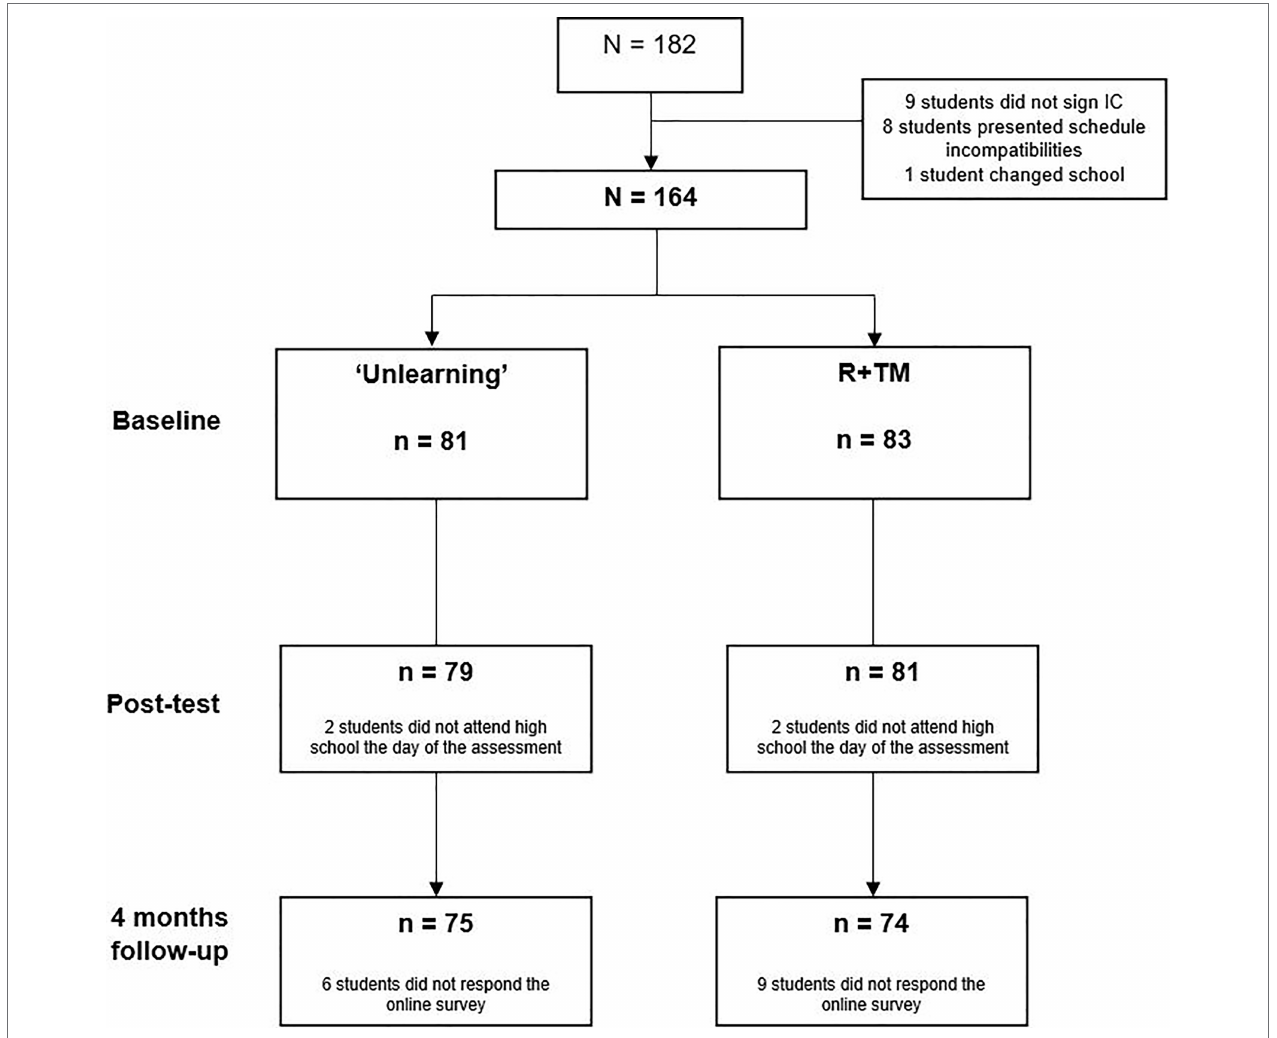
FIGURE 1 | Flow chart of participants in the randomised controlled